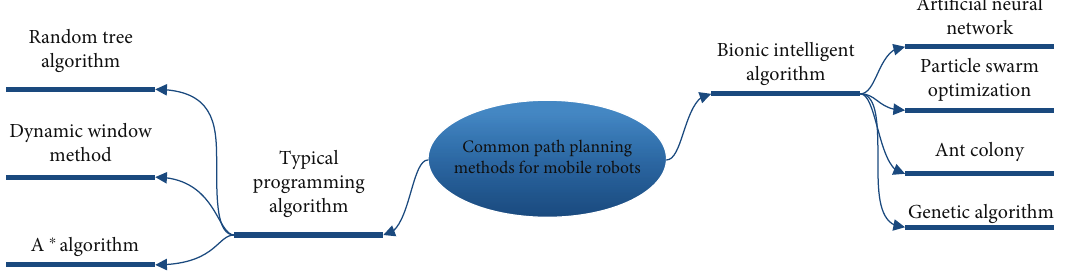
Figure 1: Common path planning algorithms for mobile